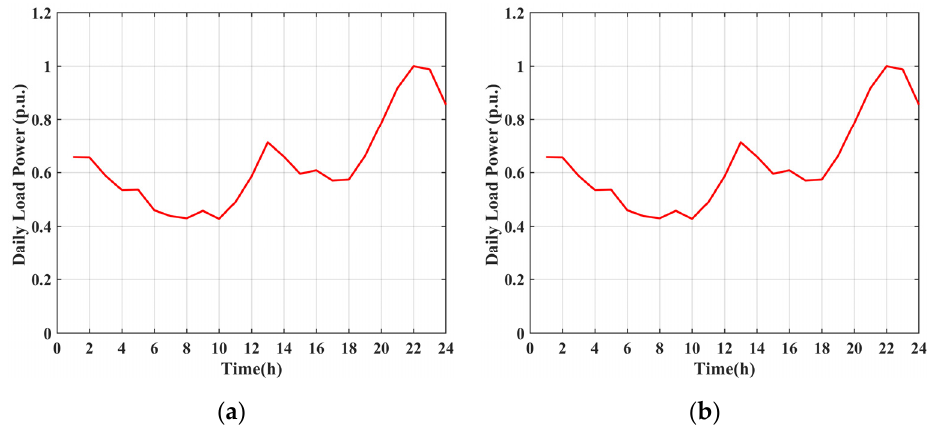
Figure 3. Typical daily load power per unit: ( a ) weekday ( b ) weekend.